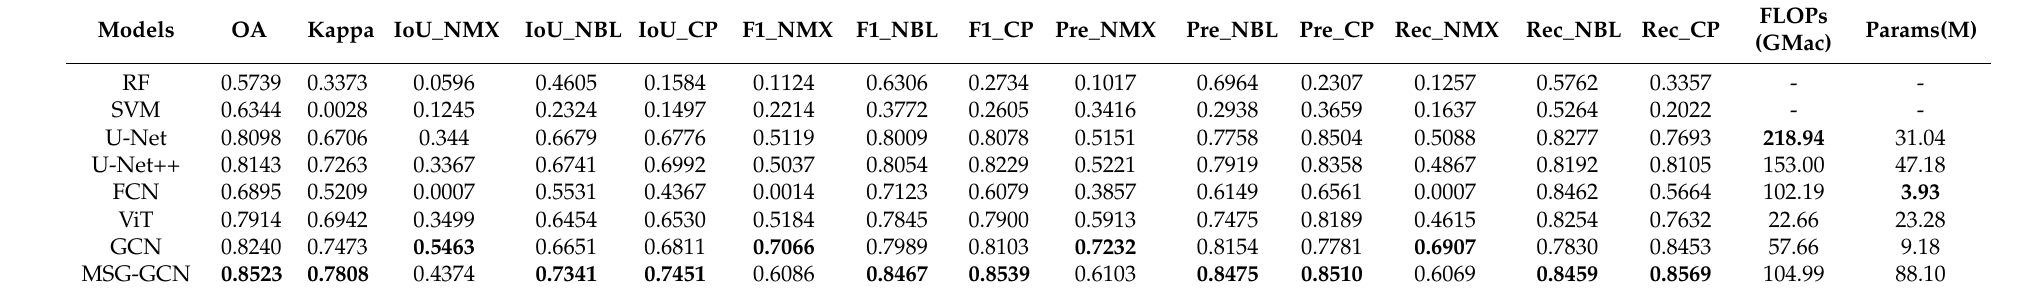
Table 1. Performance comparison of the seven methods. Accuracy, parameters, and FLOPs are listed as a function of model size on the aerial photo. The best results are in bold.